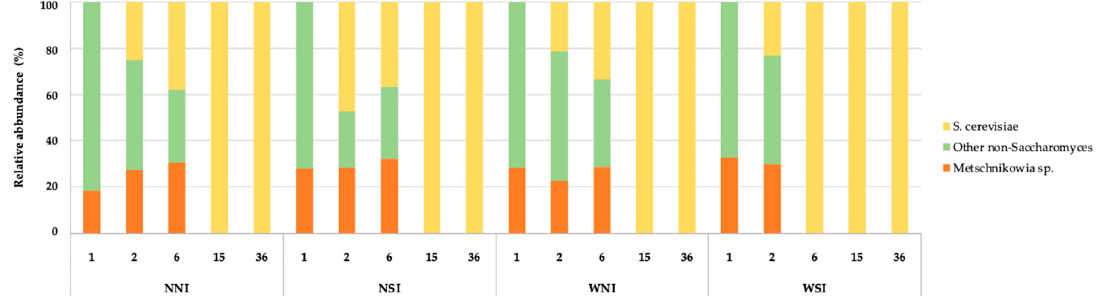
Figure 5. Yeast population dynamics in the fermentations inoculated (I) with Metschnikowia sp. DBT012 and sequentially with S. cerevisiae EC1118 after 48 h, in four different grape musts. Non-washed grapes without SO 2 (NNI), non-washed grapes with SO 2 (NSI), washed grapes without SO 2 (WNI), washed grapes with SO 2 (WSI).